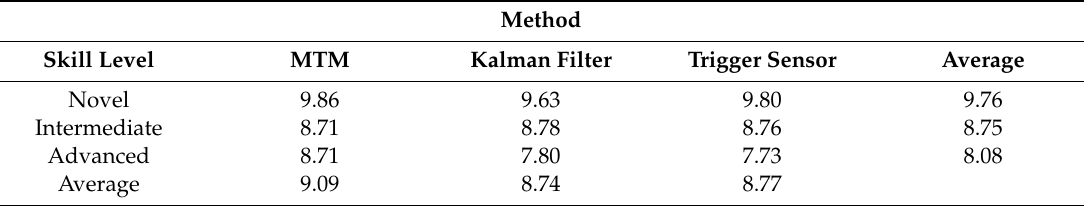
Table 2. Average cycle time for three skill level groups under three handover prediction models.